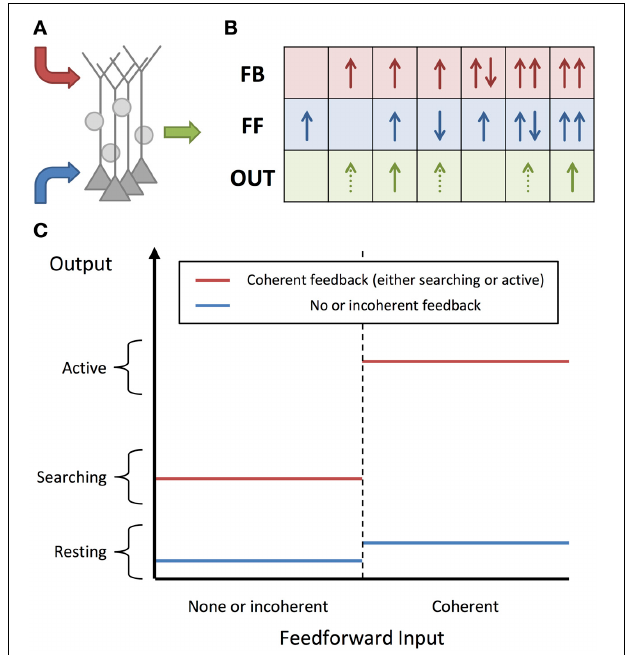
FIGURE 1 | Diagram of Model. (A) A cortical unit, composed of pyramidal neurons and inhibitory interneurons, exhibits activity (green) based on the feedforward, basal/soma-targeted (blue) and feedback, apical-target (red) inputs it receives. (B) Table describing how the unit activity depends on these inputs, as described by Equations (2) and (3). The inputs and outputs are shown by solid and dashed arrows, which correspond to active and searching inputs/outputs, respectively. The direction of each arrow indicates the phase of gamma oscillations (active) or the timing of sporadic, feedback-propagating bursts (searching). The different rows correspond to feedforward and feedback inputs, and unit output, respectively. Multiple feedforward or feedback arrows indicate multiple inputs of these types. Note that the same effects are achieved with sporadic, bursting feedback inputs (but not so for feedforward inputs). (C) Modulating effect of feedback on a unit’s responsiveness to feedforward input, as described by Equation (2) . Without feedback, the unit will remain in the resting state, regardless of the feedforward input. Coherent feedforward input must be coherent within itself but also with any feedback